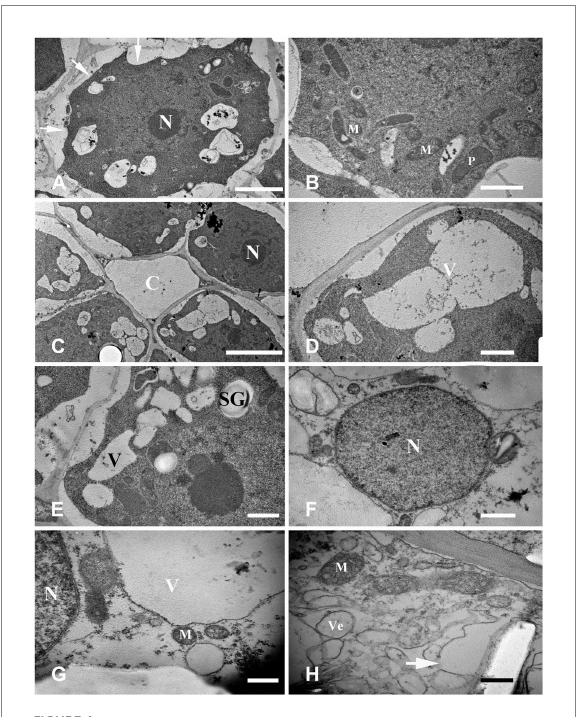
FIGURE 4 Cell ultrastructure of aerenchyma formation in Nelumbo nucifera roots (I). (A,B) The cells in the aerenchyma stationary stage have dense cytoplasm, large nucleus, multiple small vacuoles, and abundant organelles. (C–H) The cells in the aerenchyma formation stage. (C) Cavity formed between cells; (D) multiple small bubbles fusion into a larger one; (E) starch granules appear; (F) the “plastid ring” structure around the nucleus; (G) formation of the connecting strand; and (H) the rupture of vacuole membrane and the formation of membrane-like structure. M, mitochondria; N, nucleus; P, plastid; C, cavity; SG, starch grain; V, vacuole; and Ve, vesicle. Bars: A = 2 μ m, C = 5 μ m, G,H = 0.5 μ m, and others = 1 μ